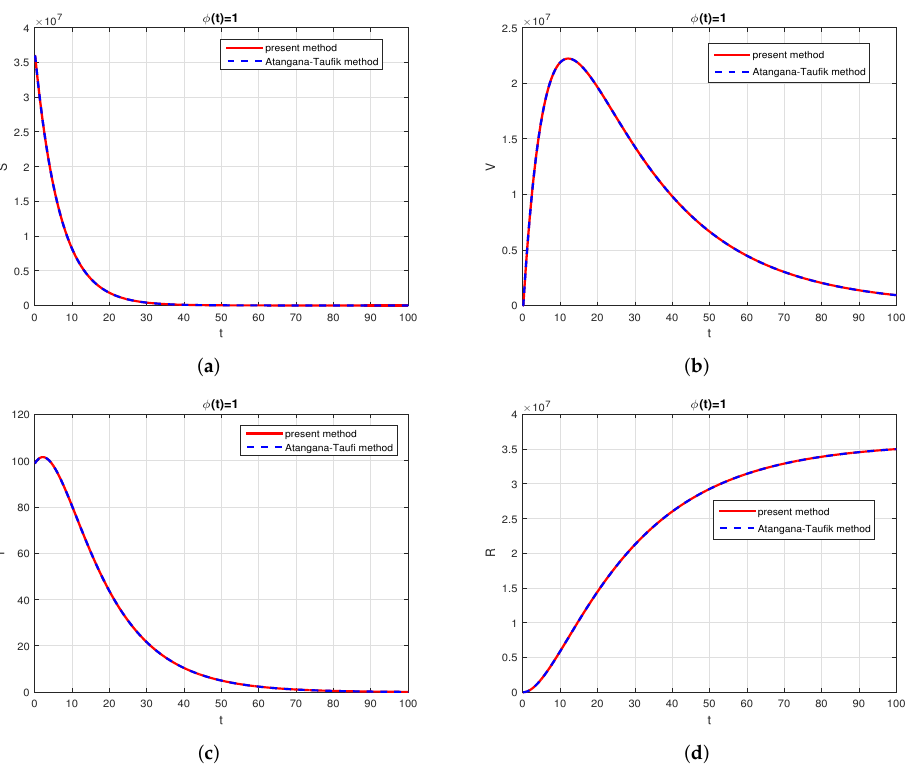
Figure 9. Comparison of the present method with Atangana–Taufik method, for q = 1, q 1 = 1, and φ ( t ) = 1. Subfigure ( a ) shows the comparison of the schemes for healthy population when φ ( t ) = 1 and q = q 1 = 1. Subfigure ( b ) shows the comparison of the schemes for vaccinated population when φ ( t ) = 1 and q = q 1 = 1. Subfigure ( c ) shows the comparison of the schemes for infected population when φ ( t ) = 1 and q = q 1 = 1. Subfigure ( d ) shows the comparison of the schemes for recovered population when φ ( t ) = 1 and q = q 1 =